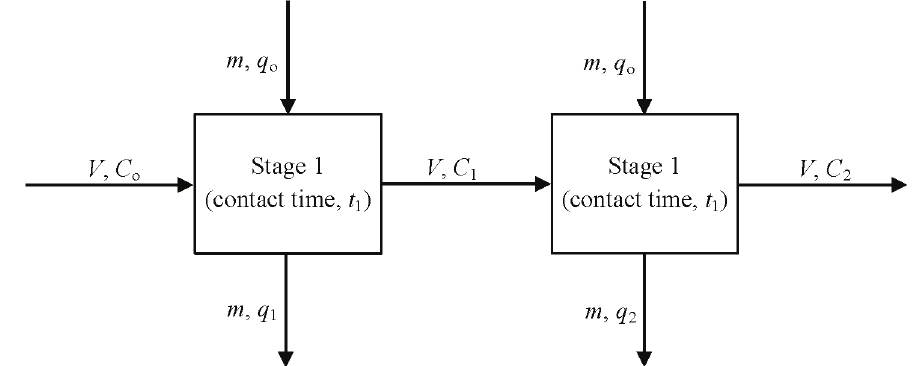
Fig. 1 – Schematic diagram of the two-stage batch sorption